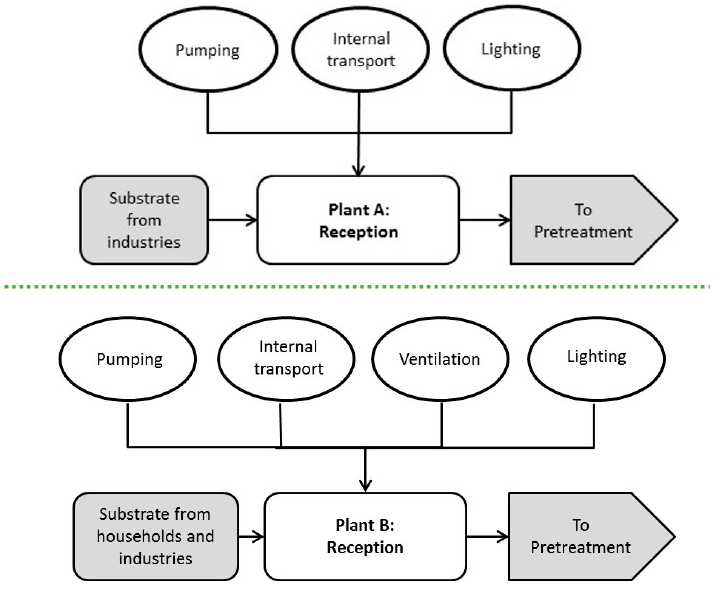
Figure 3. The connection between the sub-process reception and unit processes at biogas plant A and B, respectively. B,